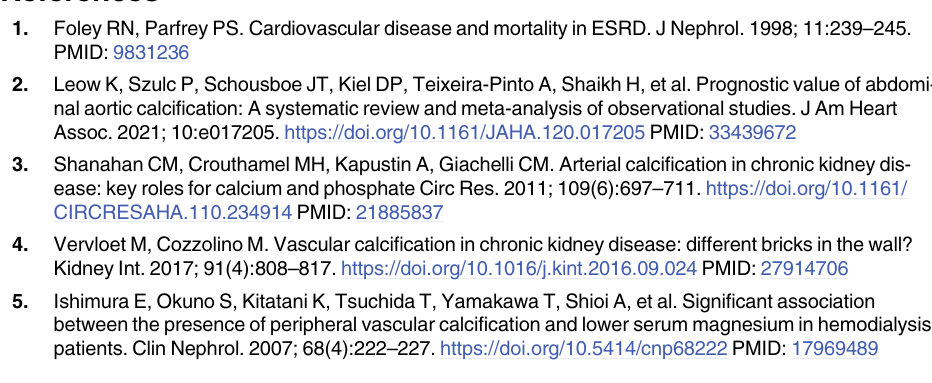
S2 Table. Univariate linear regression for serum Mg